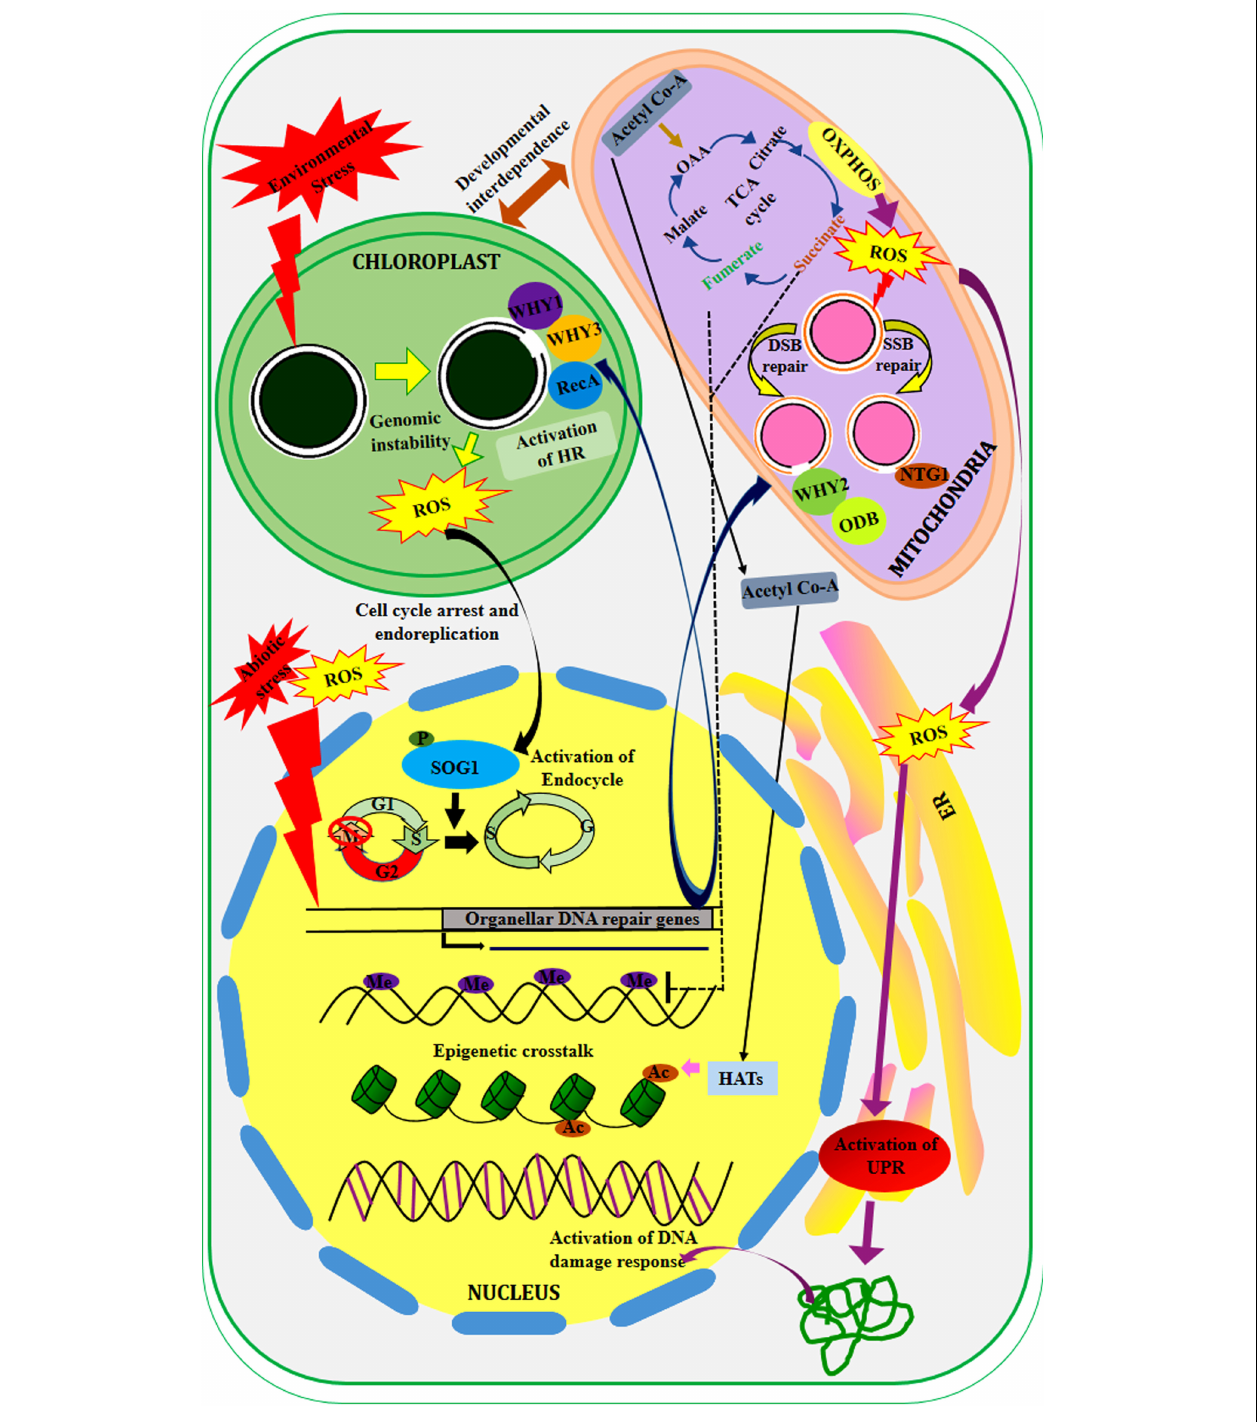
FIGURE 4 | Inter-compartmental crosstalk in the plant cell. The organelles are developmentally interdependent. The mutation of chloroplast genes affects the expression of several important genes (not shown here). In response to different environmental stress, the chloroplast genome become unstable which leads to the production of ROS in this compartment. This signal is received by the transcription factor, SOG1 that promotes endoreduplication and cell cycle arrest in the nucleus. While the nuclear-encoded proteins related to organellar DNA repair of both single and double-strand break repair are transported to the chloroplast (WHY3, WHY1, and RecA) and mitochondria (WHY2, ODB, NTG1) via anterograde signaling. The products of the TCA cycle (Succinate and fumarate) epigenetically modulate the gene expression via activation or repression. Moreover, the metabolic by-product (ROS) generated in mitochondria activates unfolded protein response (UPR) in ER which subsequently promotes DNA damage response in the